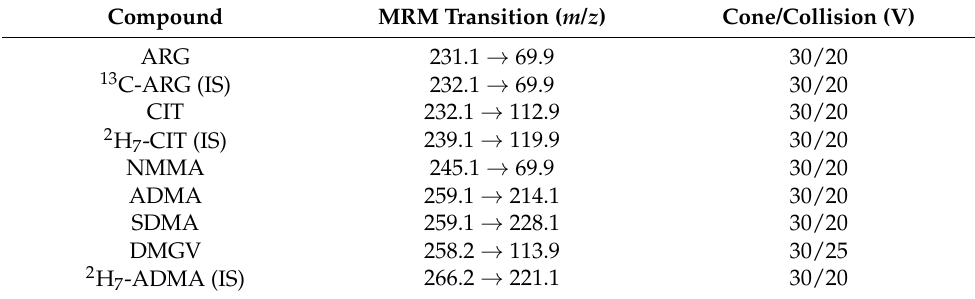
Table 4. Multiple reaction monitoring (MRM) transitions used for LC-MS/MS